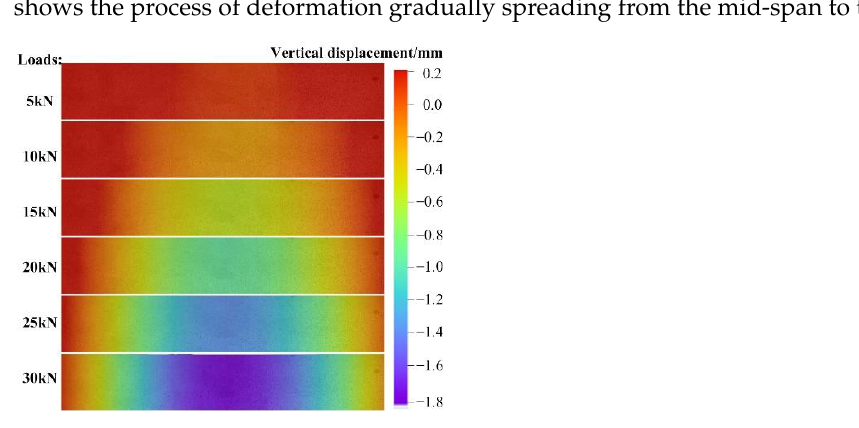
Figure 12. Results comparison of MC-DIC and displacement transducer.